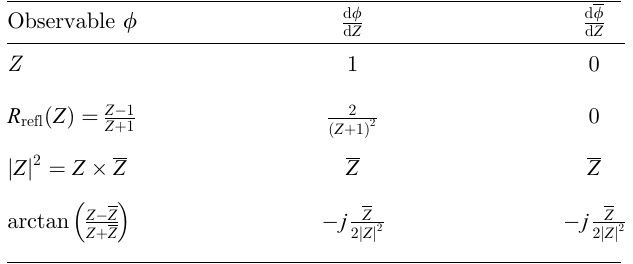
Table 4. Complex derivative with respect to Z of different observables. For real observables the two derivatives are equal. The phase and modulus of R refl can be obtained by